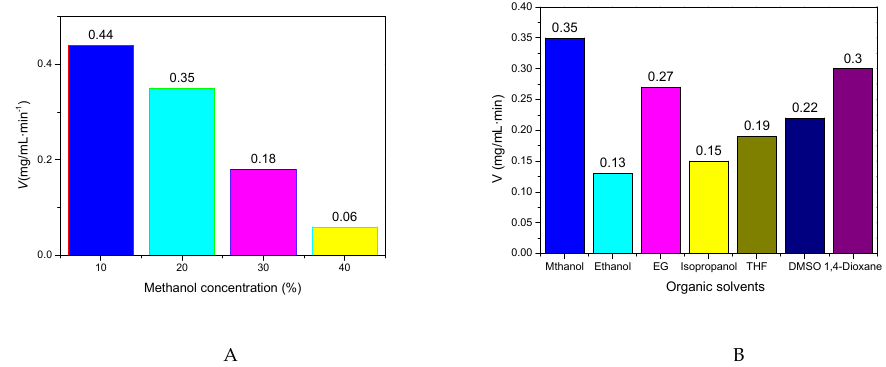
Figure 7. Effect of different additives on the reaction rates of cephalexin.